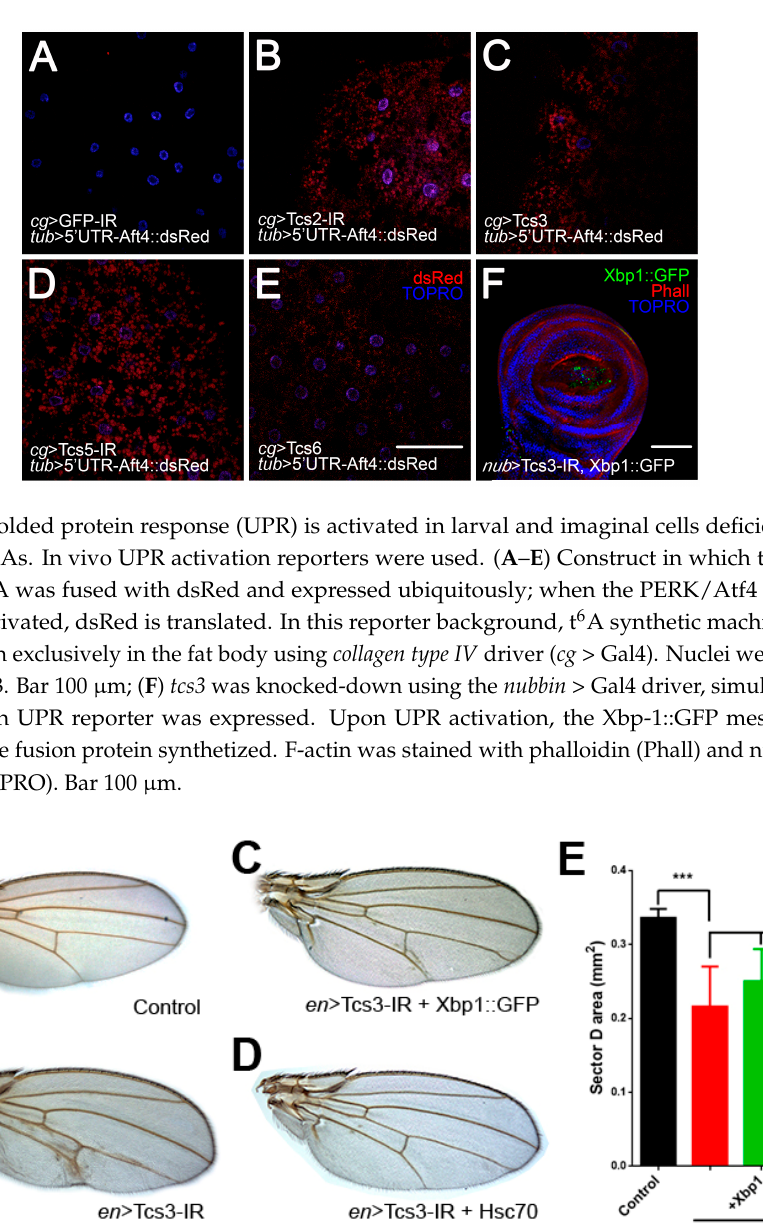
overexpressed ( C ) Xbp1::GFP or ( D ) Hsc70. ( E ) Quantification of the area of sector D ( n = 15, ANOVA,